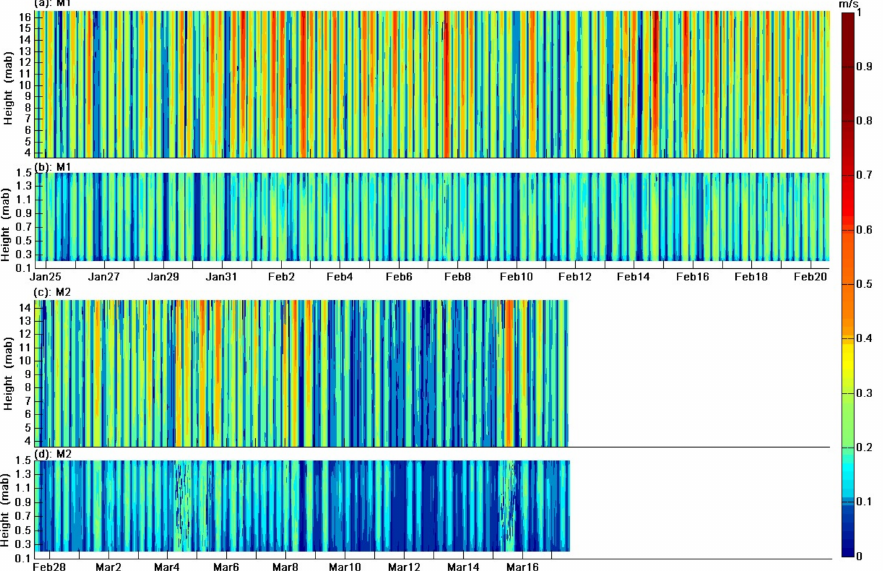
Figure 4. Original velocity profile at full water depth measured by upward-looking ADCP and downward-looking PCADP. ( a ) Vertical profile of current velocity in the middle and upper layers of the water body at M1 station, measured by upward-looking ADCP. ( b ) Vertical profile of current velocity in the near bottom layers of the water body at M1 station, measured by downward-looking PCADP. ( c ) Vertical profile of current velocity in the middle and upper layers of the water body at M2 station, measured by upward-looking ADCP. ( d ) Vertical profile of current velocity in the near bottom layers of the water body at M2 station, measured by downward-looking